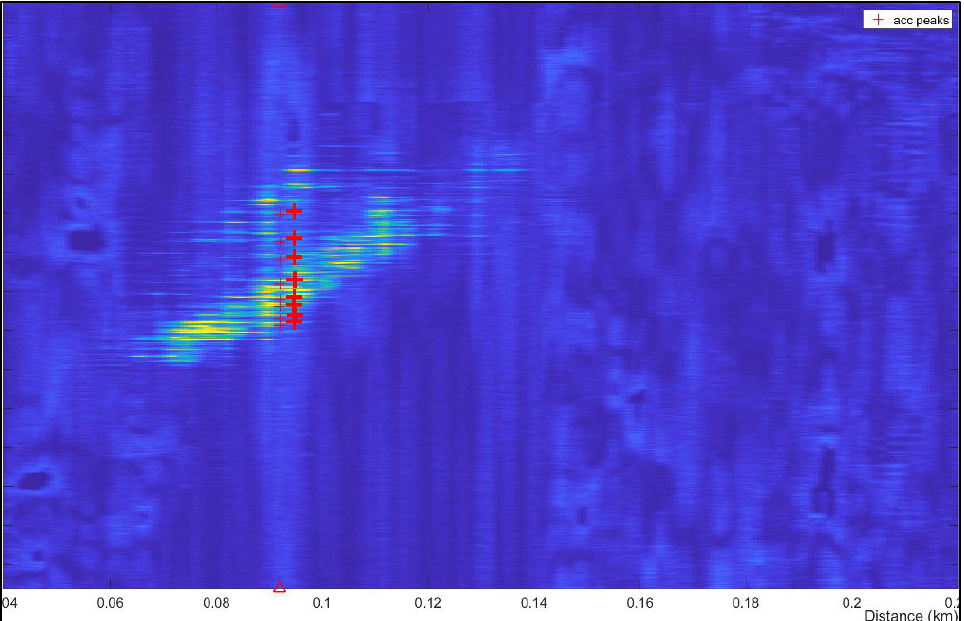
Figure 11. 2-D sinusoidal convolution with a 25 mm gap and a speed of 25 km/h, vertical axis is time, horizontal axis is distance. time, horizontal axis is